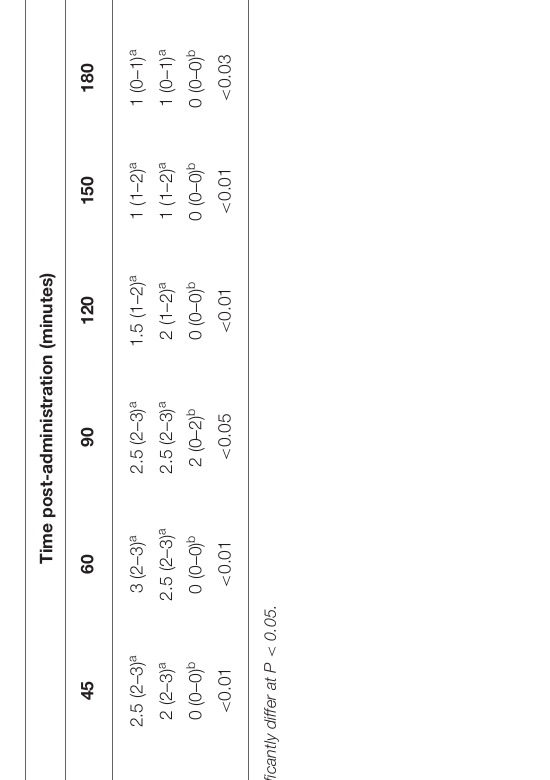
in interneuron transmission of norepinephrine and substance- p, which is involved in nociception, resulting in reduced neural activities and anti-nociception (25, 26). The magnitude of anti- nociception provoked by epidural administration of RO in our study could also be attributed to systemic action following absorption through vascular or lymphatic structures in the epidural space. In camels, intravenous RO has been shown to produce comparable levels of anti-nociception (17). We diluted RO in a relatively large volume of normal saline in our study, allowing the drug to migrate cranially to the sacral, lumbar, and thoracic spinal cord segments, implying that its actions were both local and